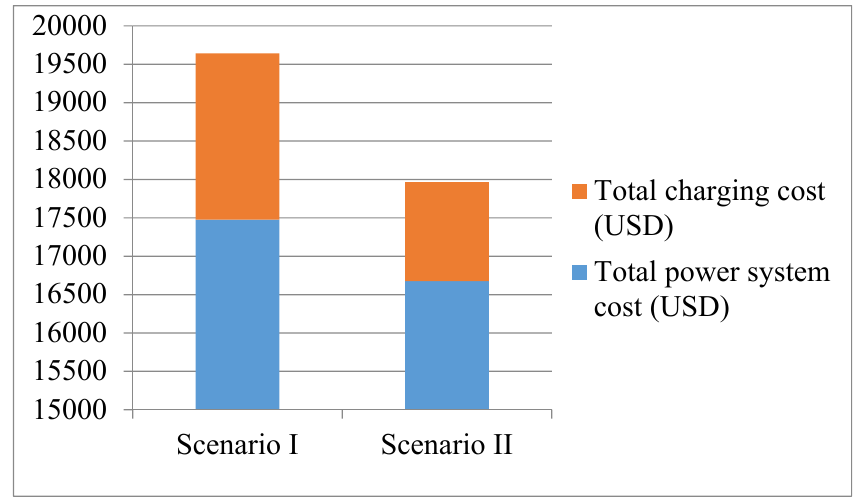
Figure 15. Total charging cost and total power system cost for one hour in presence of PHEVs.